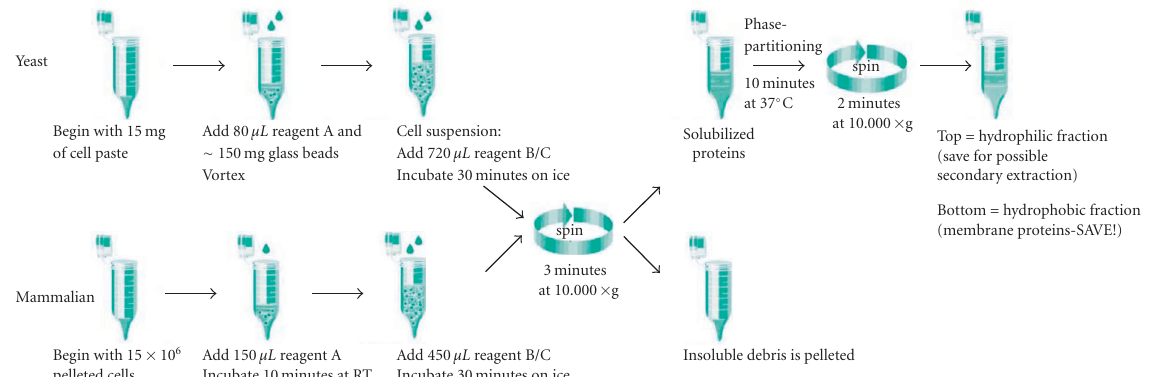
Figure 1. Schematic of Mem-PER Eukaryotic Membrane Protein Extraction Kit protocol. Each step of the procedure is outlined for a single extraction of either mammalian or yeast membrane